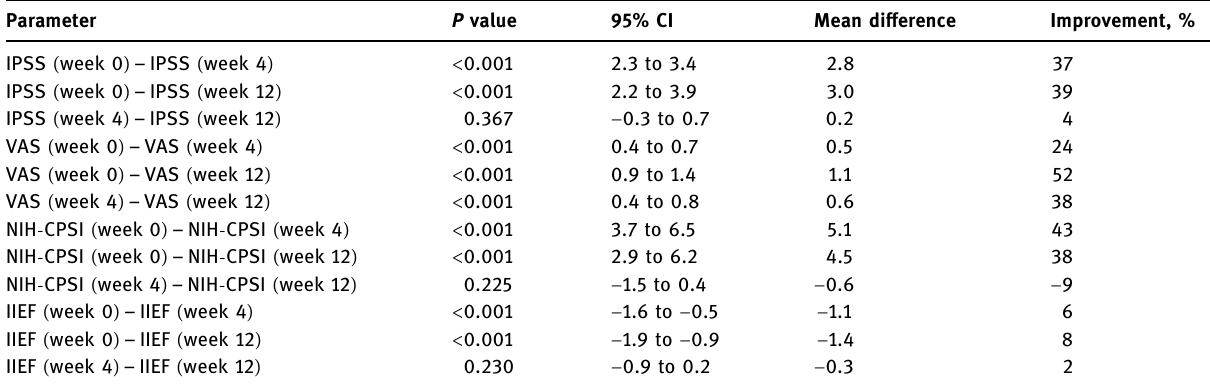
Table 1: Results: changes in